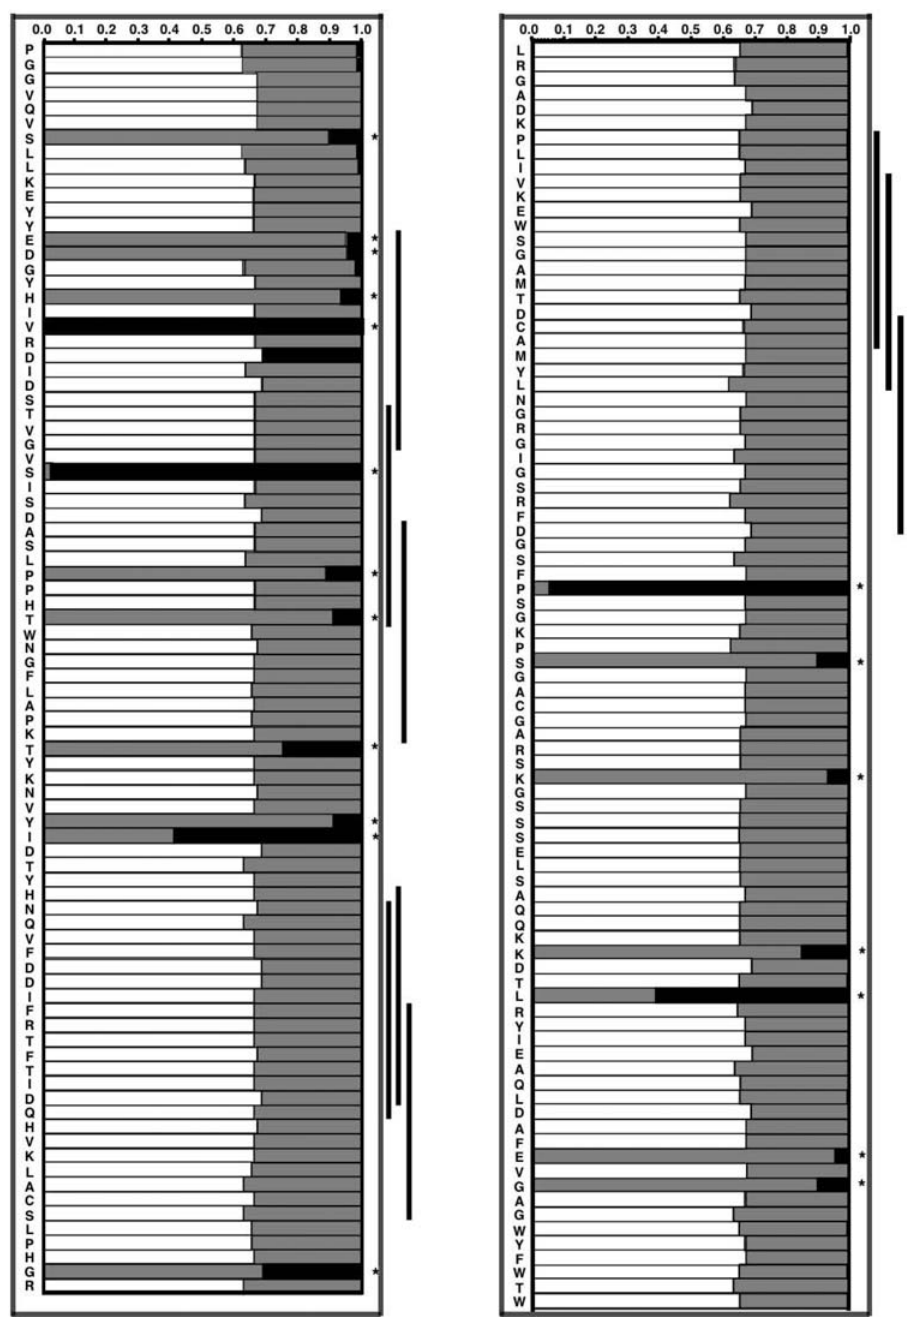
Figure 3. Posterior probabilities showed by each site in the exon 2 of the PBGP43 gene belonging to site classes with different selective pressures (of 18.20 [black], 1.58 [gray], and 0.00 [white bars]) under the free-ratio model. The gp43 amino acid sequence is shown to the left. Sites with a posterior probability higher than 95% have a greater than 1 and are indicated by an asterisk (*). The underlined parts correspond to the regions that according to SYFPEITHI prediction are potential